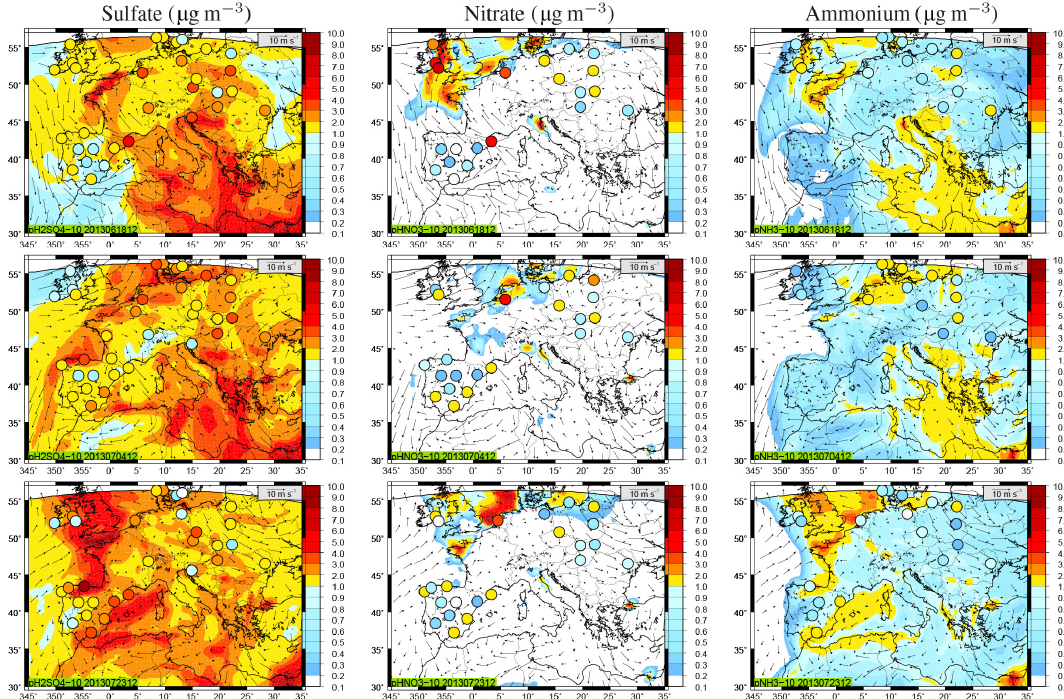
Figure 8. Maps of sulfate, nitrate and ammonium (µgm − 3 ) for 18 June, 4 and 23 July 2013. A magnification is done over western Eu- rope where EMEP surface measurements (superimposed to the model) are available. All concentrations values lower than 0.2µgm − 3 are considered to be nonsignificant and are not colored. The 10m (a.g.l.) wind speed is superimposed as